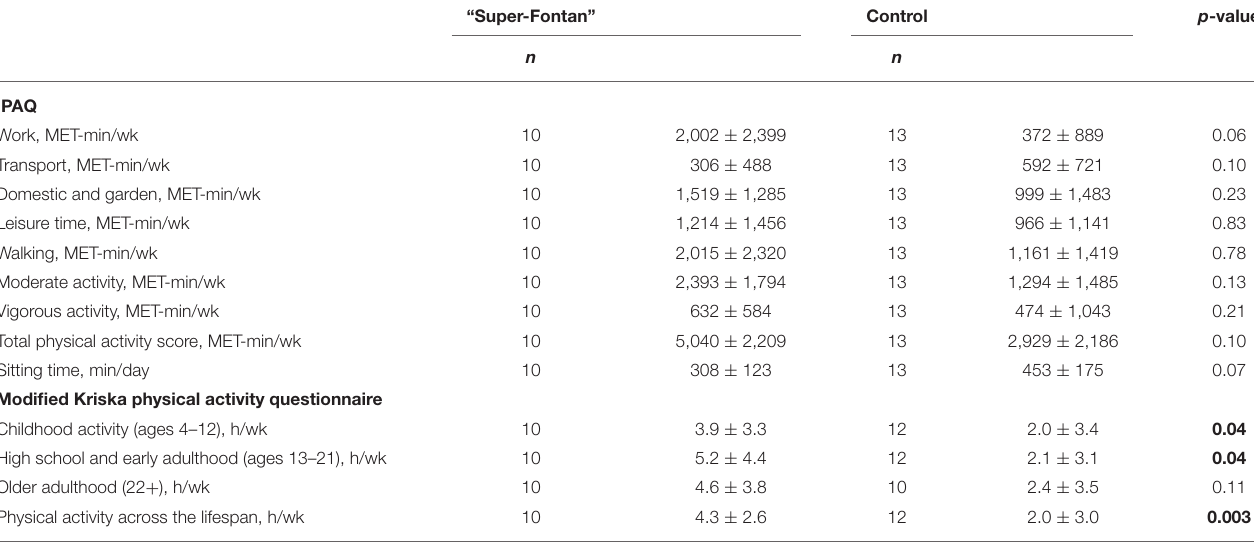
TABLE 4 | The international physical activity questionnaire (IPAQ) and modified Kirska questionnaire results. “Super-Fontan” Control p